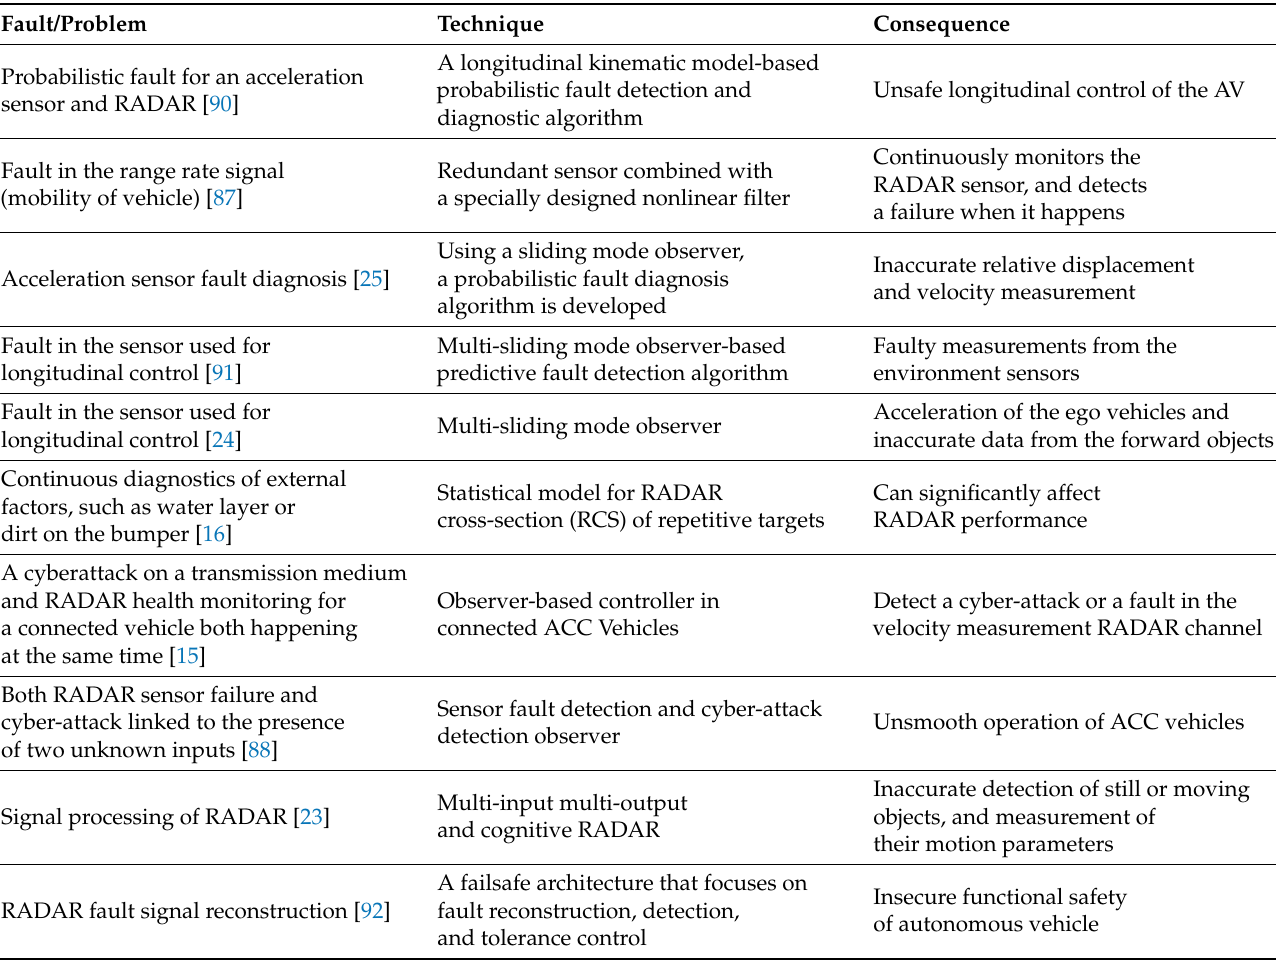
Table 6. Demonstration of radio detection and ranging (RADAR) fault types and the fault detection